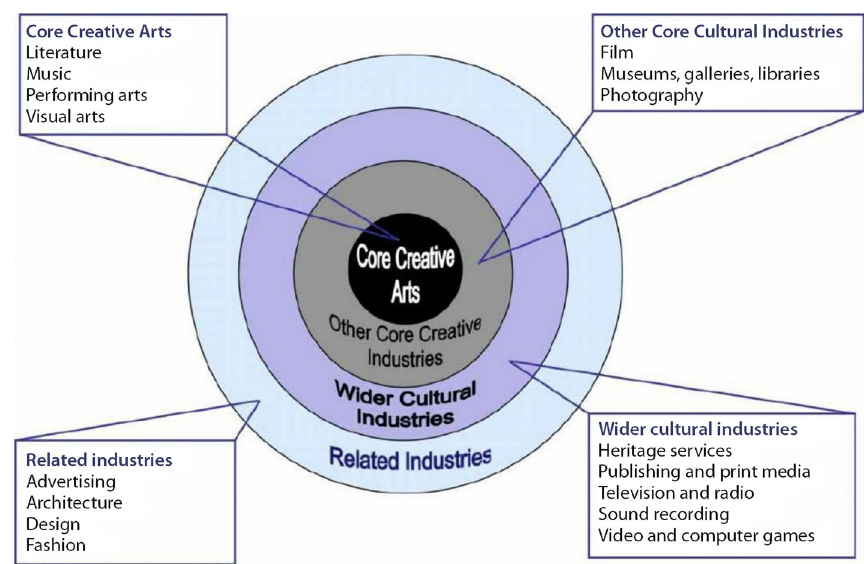
Fig. 5 The concentric circles model of the cultural industries (Source: Throsby